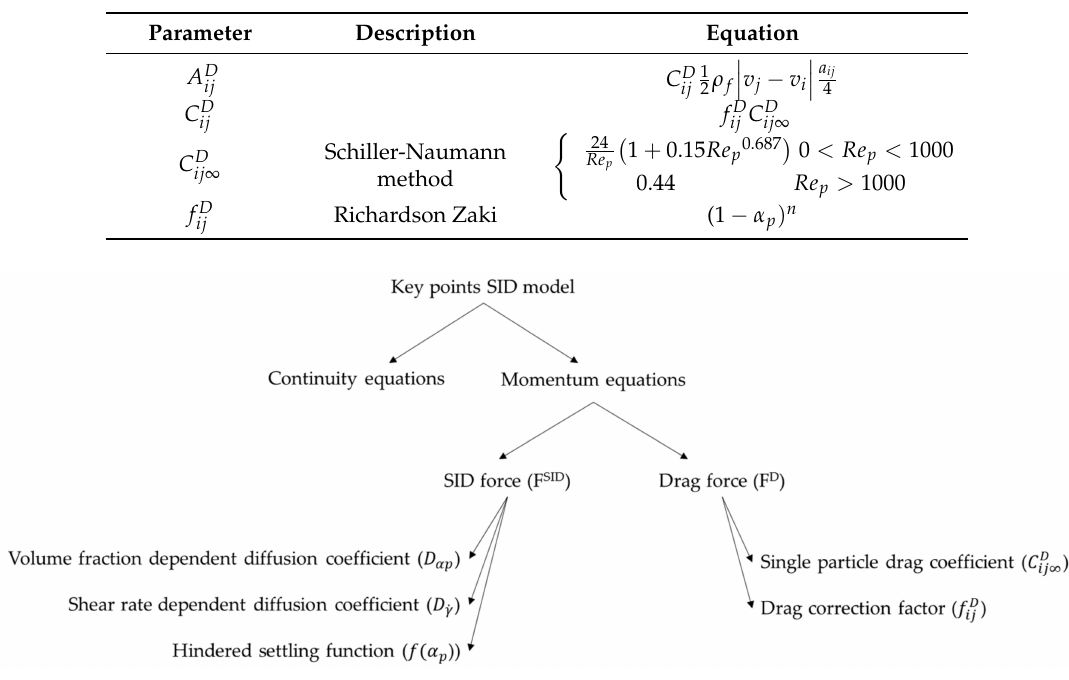
Figure 4. Flow chart of the most important steps taken in our shear induced diffusion